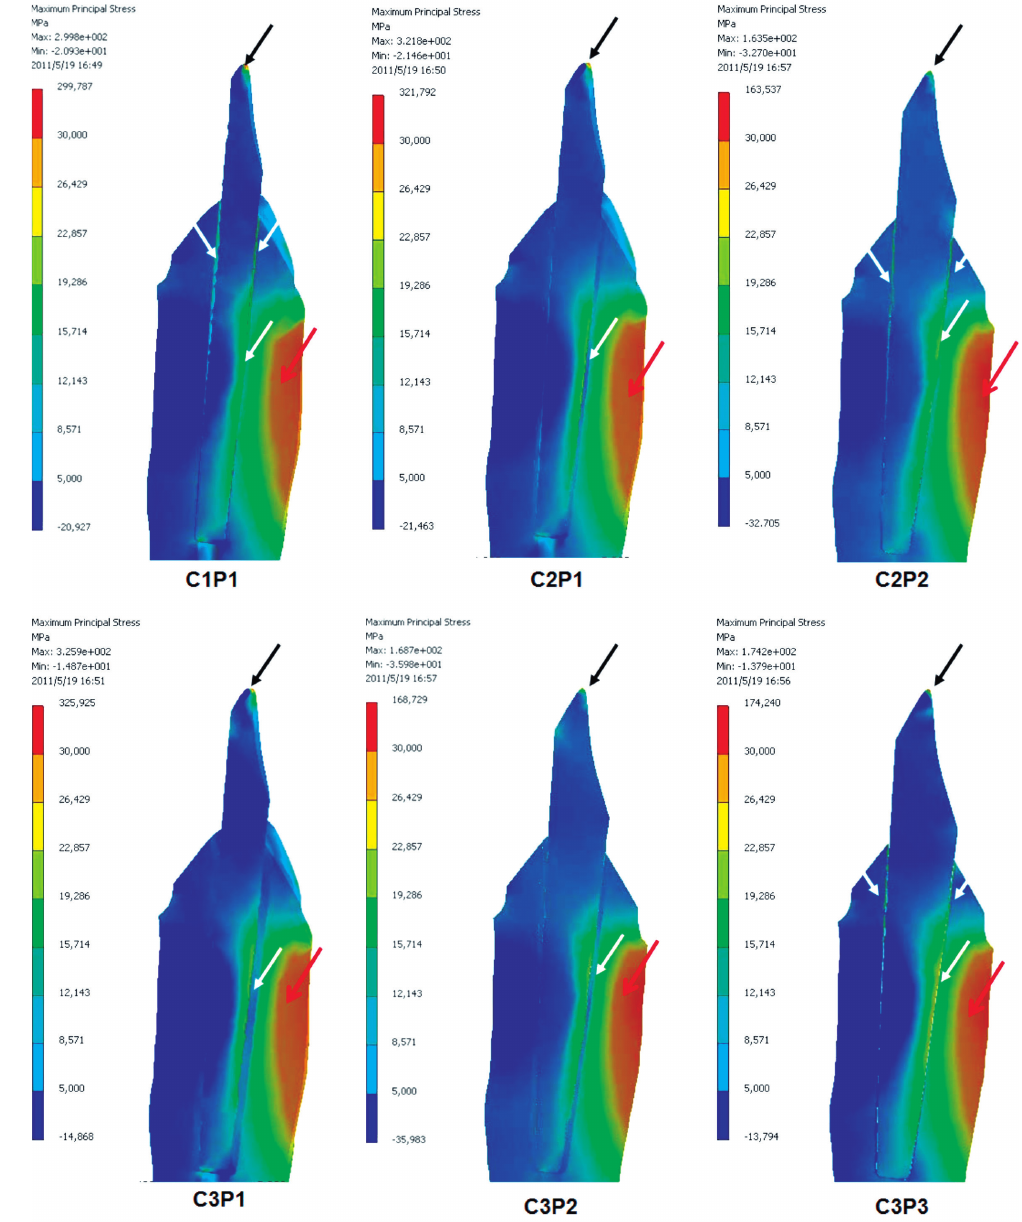
Figure 5- Stress distribution in root-filled models. The stress distributions in the glass fiber posts were similar for all models (palatine surface in the coronal and middle thirds) and the peak of maximum principal stress occurred in the incisal area of the post (black arrow). Note that the stress distributions in the cement layer (white arrows) indicate the stress concentration in the cement line. For C2P1, C3P1, and C3P2, it occurs in the middle third in the palatine surface, while for C1P1, C2P2, and C3P3, the stress concentrates at the middle and near the coronal thirds (white arrows). The stress peak in the dentin was concentrated among the coronal and middle thirds, mainly at the lingual dentin walls (red